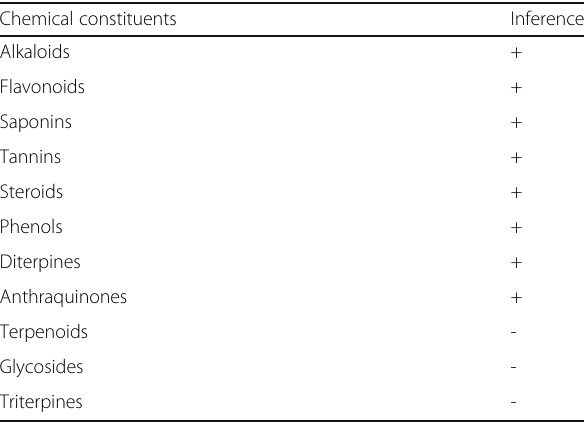
Table 1 Phytochemical profile of methanol extract of Hibiscus micranthus leaves Chemical